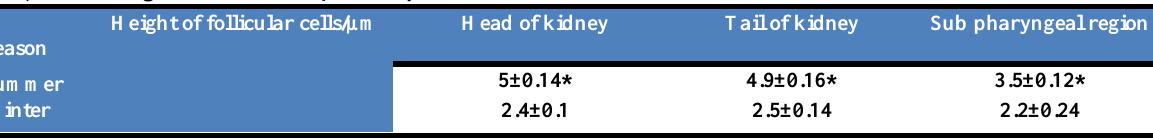
* A significant difference (P<0.05) in the height of follicular cells between summer and winter. Values =mean± SE, S= small, L=